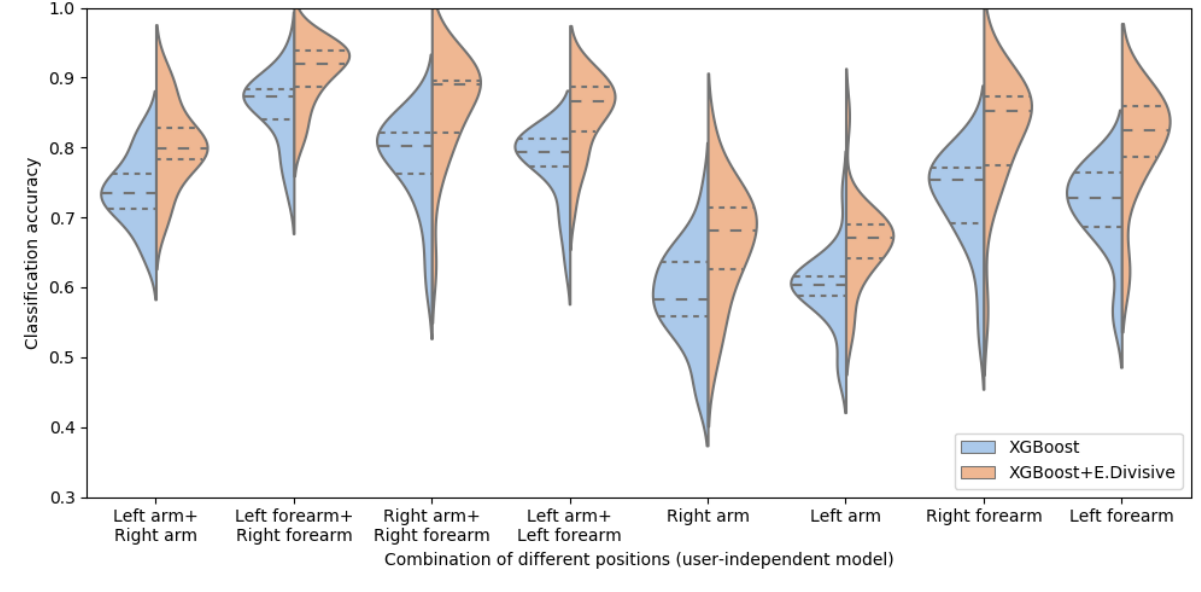
Figure 8. Classification accuracy of different combinations of armband positions: user-independent model.